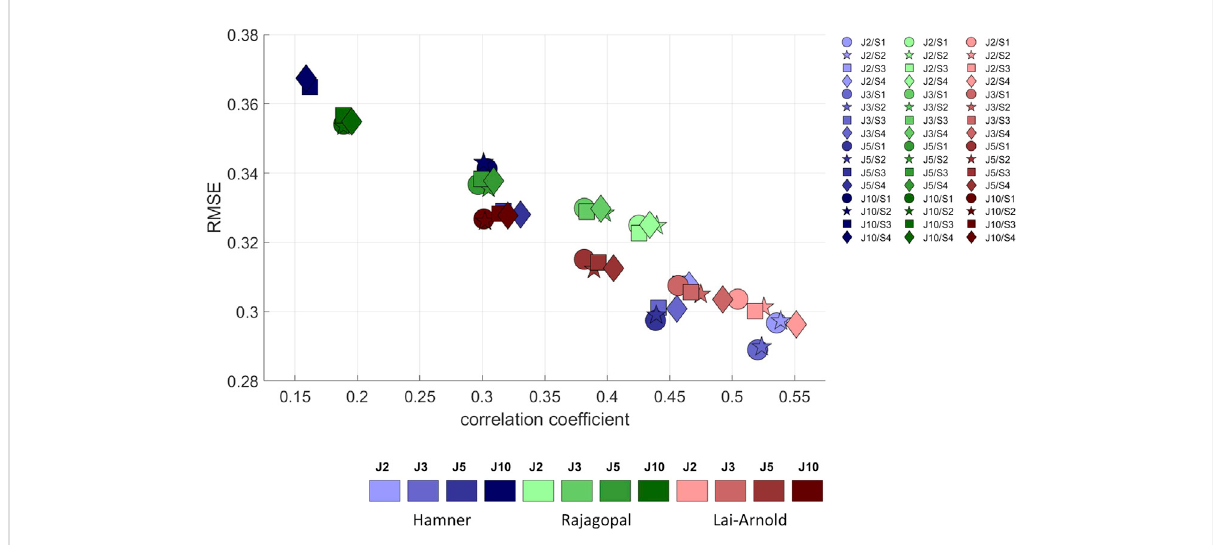
FIGURE 3 RMSE versus correlation coef fi cient (r) between normalized EMGs and estimated muscle excitations, averaged values among all subjects, speeds, and muscles, with performance criteria based on minimization of muscle effort to the power of 2 (J2), 3 (J3), 5 (J5), and 10 (J10), illustrated with darkening colors, and scaling variants of linear scaling of OFL and TSL and generic MIF (S1), non-linear scaling of OFL and TSL and generic MIF (S2), linear scaling of OFL and TSL and scaled MIF (S3), and non-linear scaling of OFL and TSL and scaled MIF